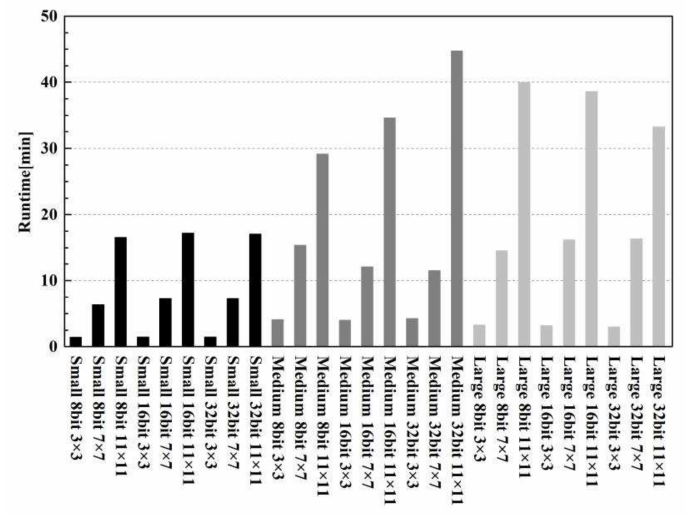
Figure 10. Runtimes of the